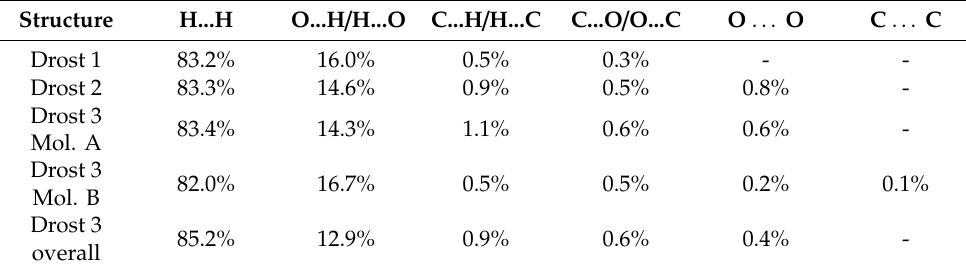
Table 4. Various contributions to the Hirshfeld surface for di ff erent interactions.